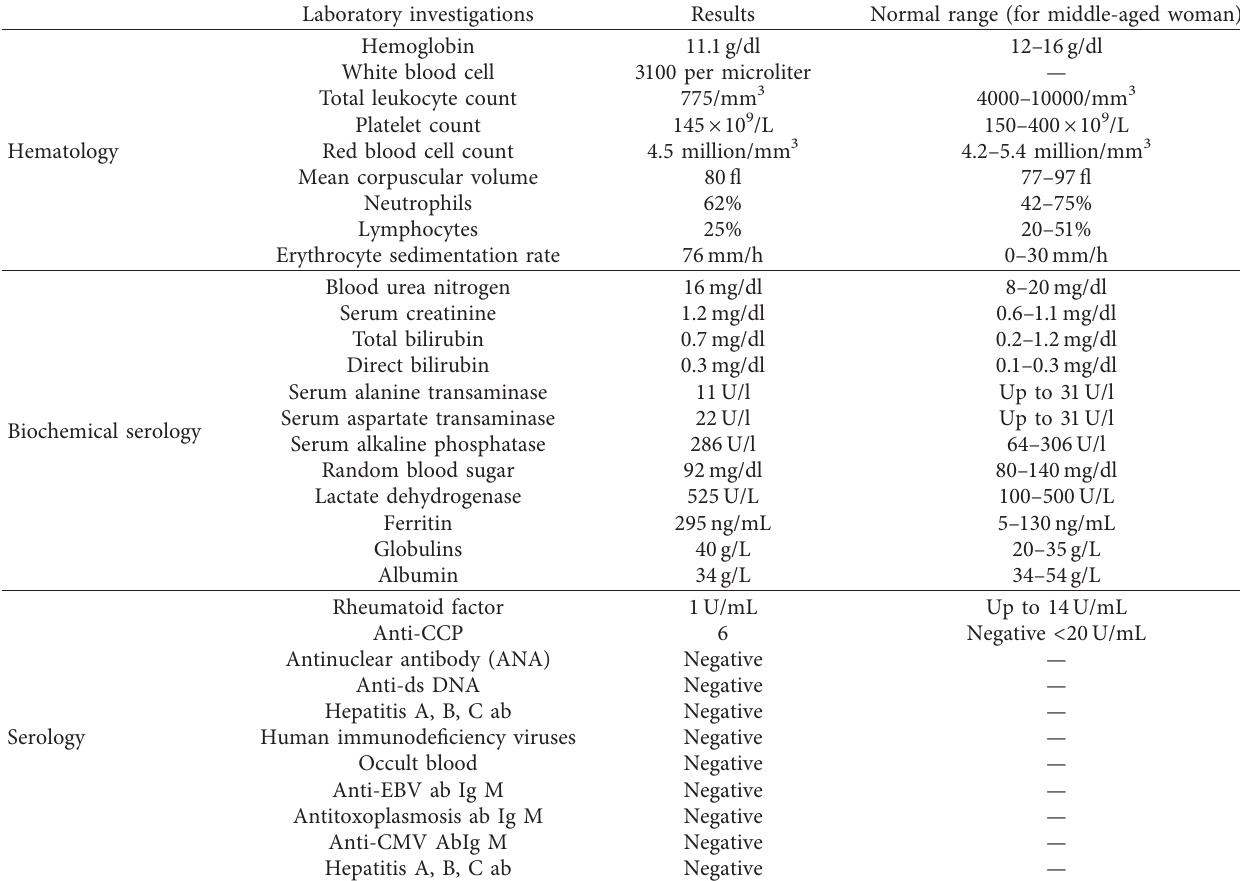
Table 1: The results of laboratory tests of the patient before the biopsy. Laboratory